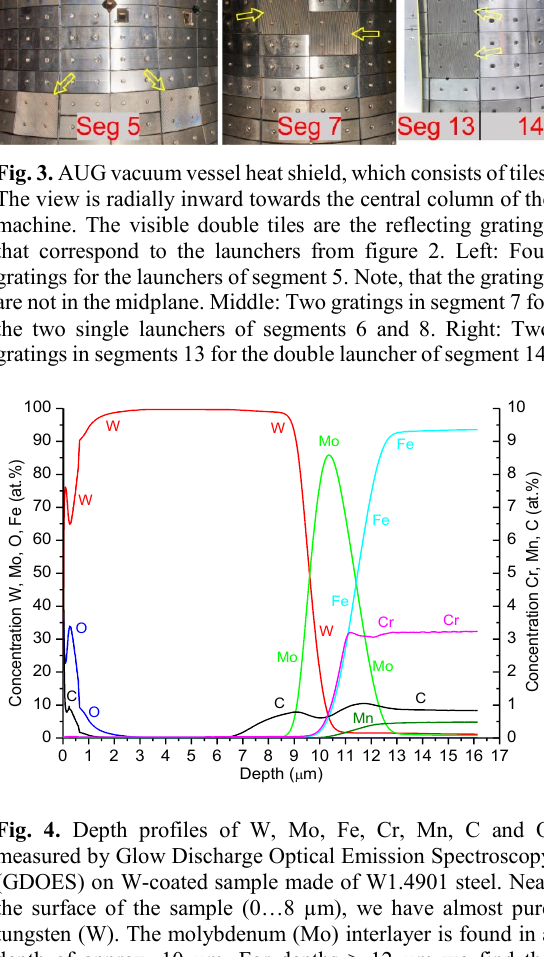
Fig. 2. ECRH launchers inside the AUG vacuum vessel, the view is radially outward. Left: Double launcher in segment 14. Middle: Single launcher in segment 8. Right: Segments 7,6,5 (from left to right) with the large port of the neutral beam input in segment 7, the single ECRH launcher in segment 6, and the four launchers in segment 5. The robust surfaces of the auxiliary limiters left of the launcher mirrors in segments 14, 8, and 6 are the design end points after the second pass. The launcher highlighted with a white circle in segment 5 (right photo) was used for the experiments described in section 4.